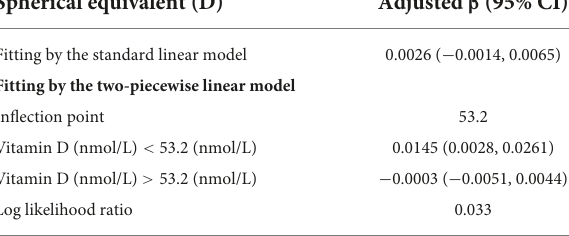
TABLE 5 Threshold effect analysis of vitamin D on spherical equivalent in male using the two piecewise linear regression